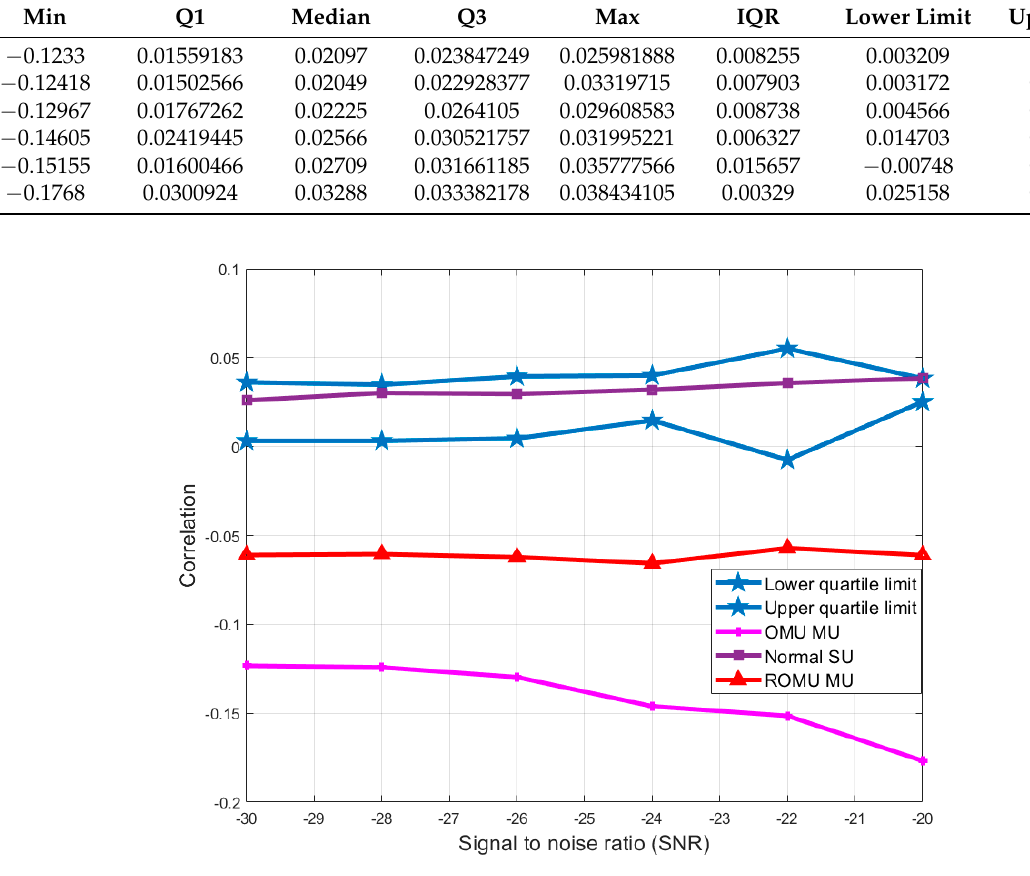
Figure 5. Correlation vs. SNR, when both the OMUs and ROMUs exist in the network.